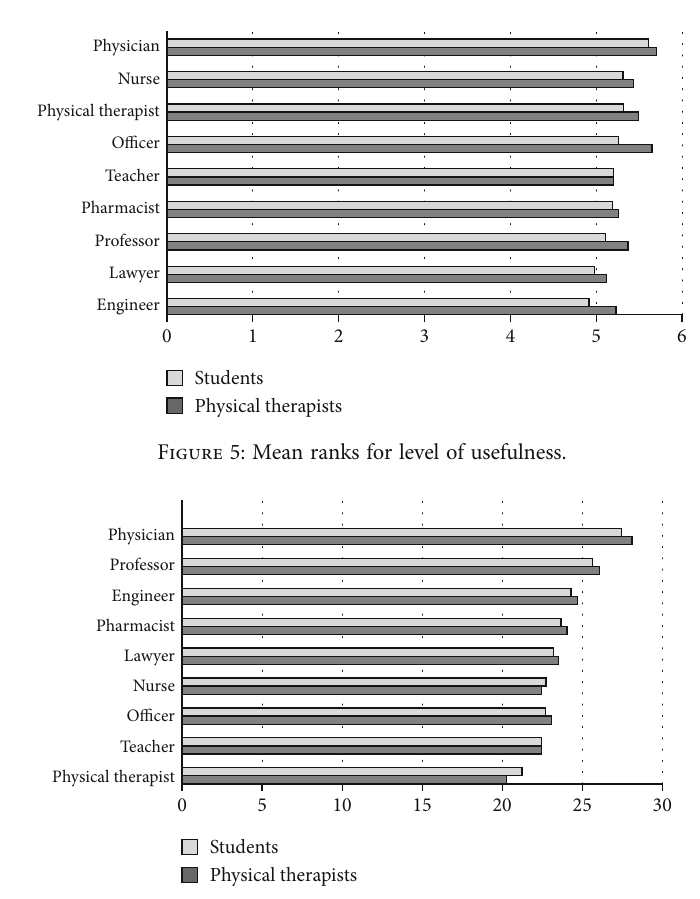
Figure 4: Mean ranks for level of responsibility.